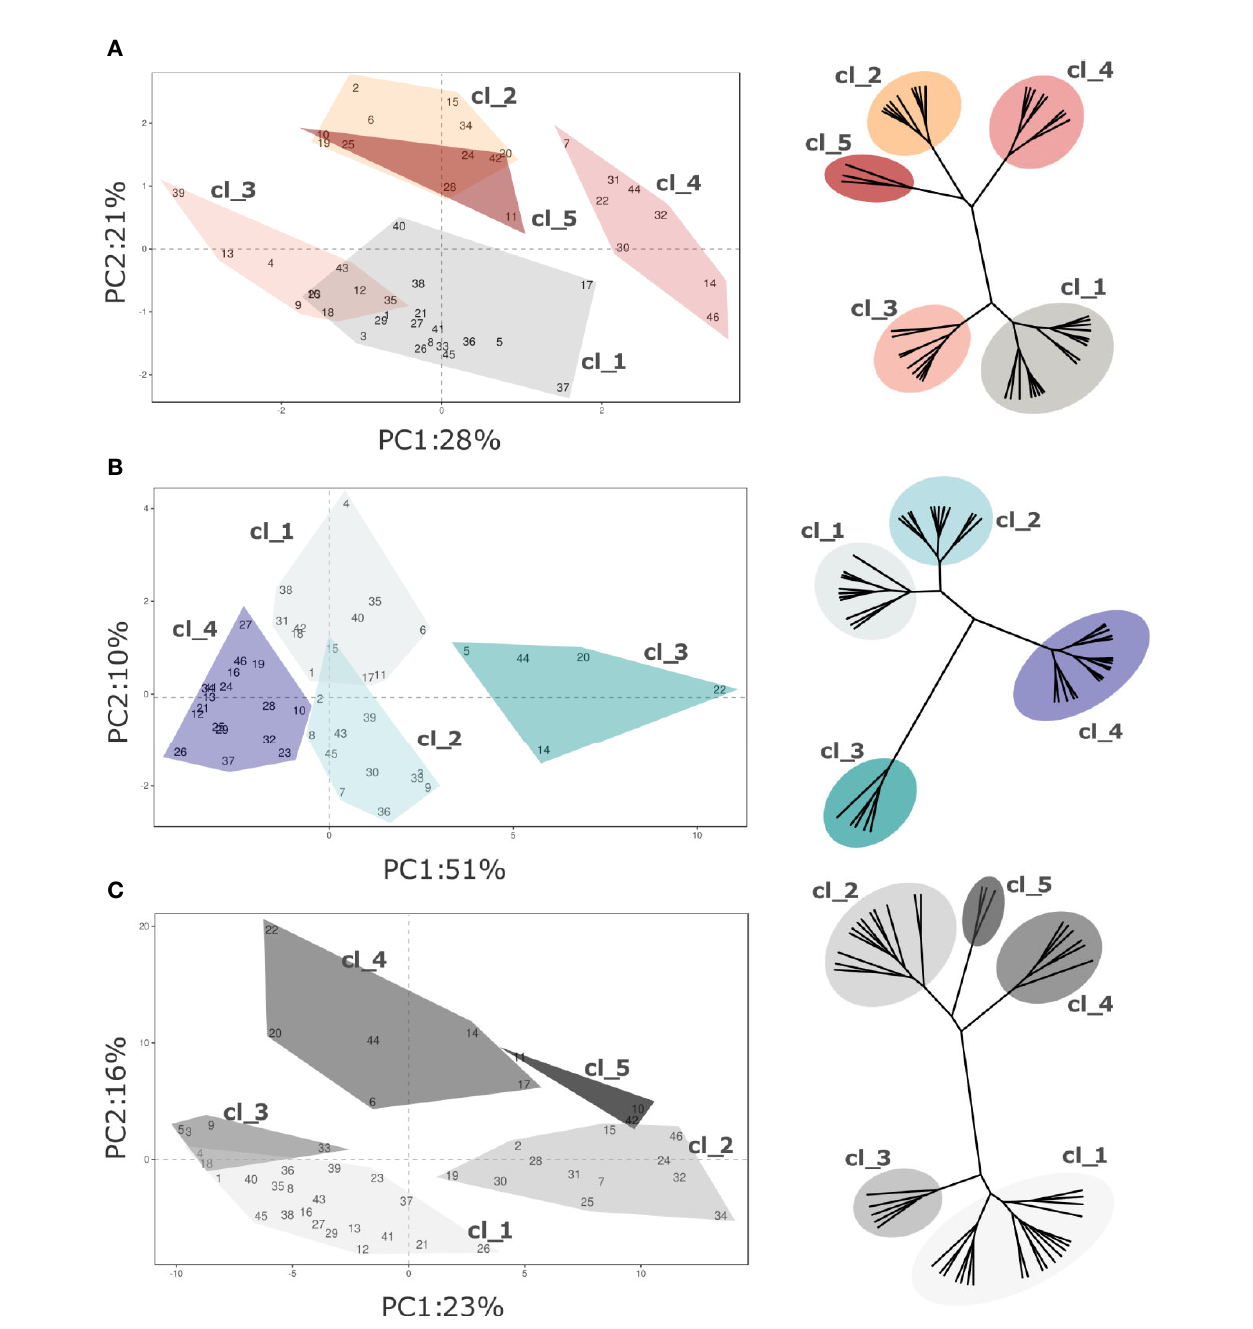
FIGURE 7 | PCA and hierarchical clustering (based on Ward distances) of 46 Vaccinium spp cultivars based on VOC pro fi le assessed at (A) harvest and (B) postharvest, and on the calculated storage index (C) . Each point of the PCA plot is the average of three measurements. Loading plots of each PCA are reported in the supplementary Figure 6 . Clusters highlighted in each PCA plot corresponds to the clusters identi fi ed by Ward